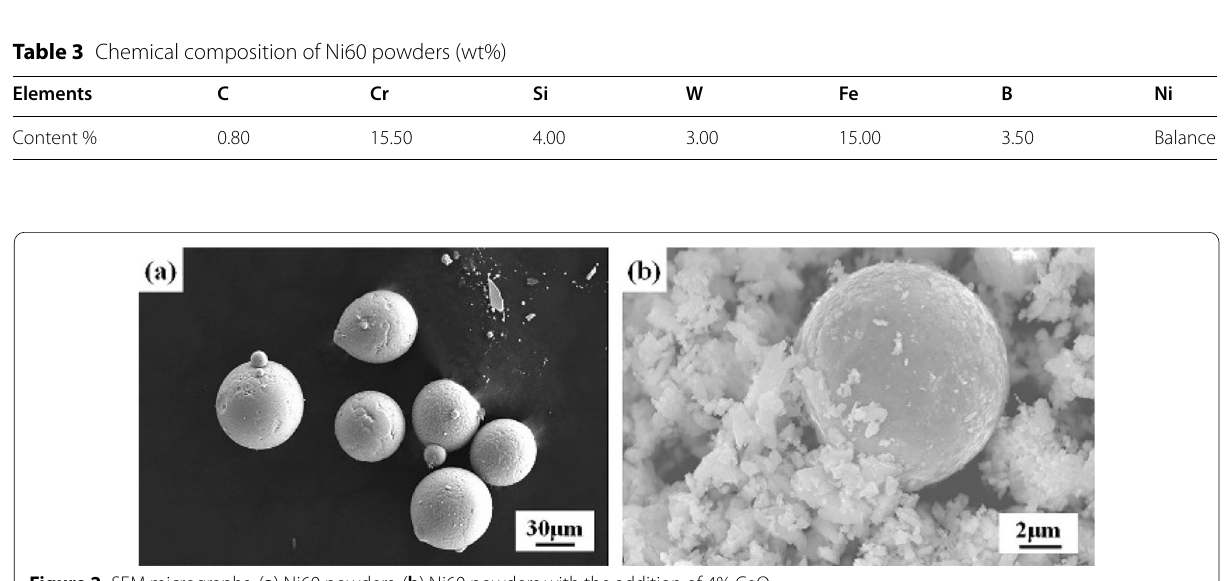
Table 2 Chemical composition of 45 steel and 304 stainless steel net (wt%) Elements C Si 304 stainless steel net